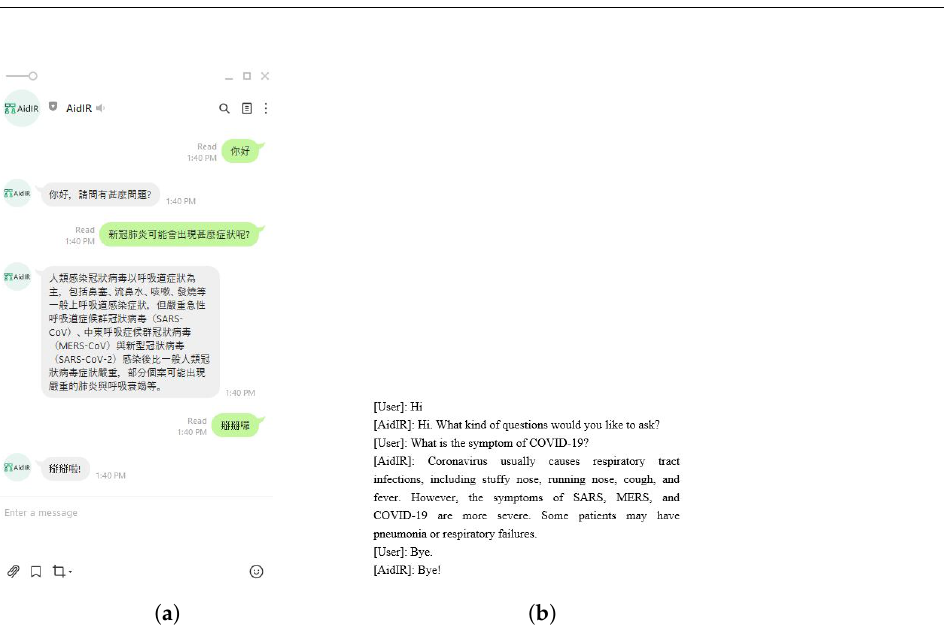
Figure 11. User provides enough information at first: ( a ) original dialog; and ( b ) dialog in English.